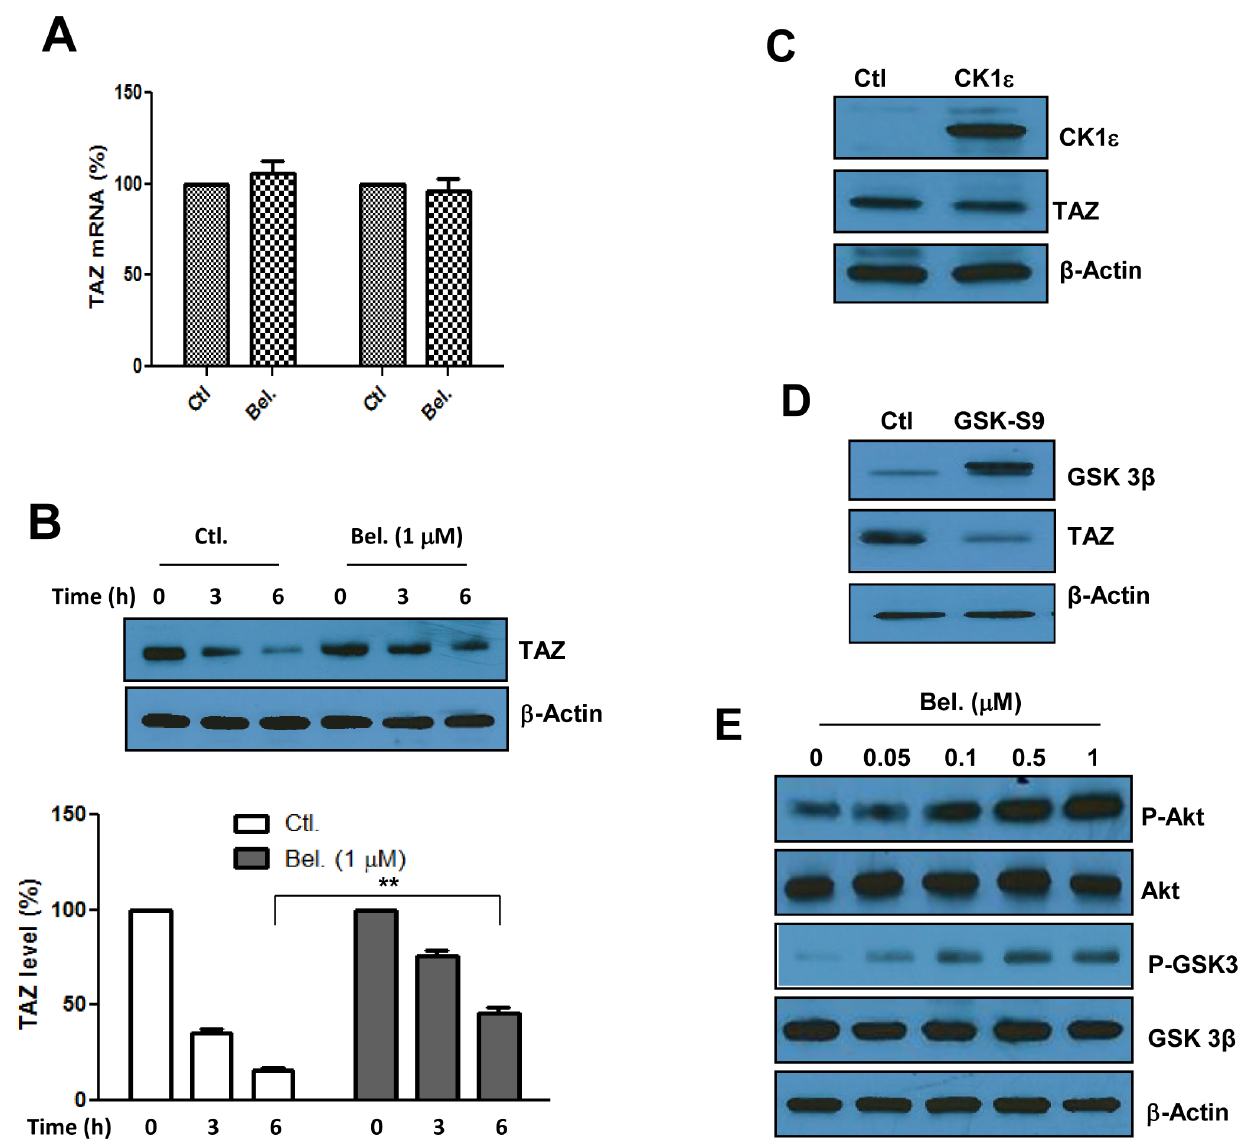
Figure 3. Belinostat-induces stabilization rather than expression of TAZ. Panel A. expression of TAZ in response to Belinostat (5 m M) measured quantitative PCR. Panel B. Effect of Belinostat on TAZ stabilization. SW480 cells were exposed to cycloheximide (CXH) at 10 m M concentration in the absence or the presence of Belinostat ( m M). Proteins were extracted at the indicated times after addition of the compounds and TAZ protein levels determined by Western blot. Band densities were quantified by the Image J software (NIH) and graphed. Data in graphs A and B represent average of three determinations 6 SE. Significance (p , 001) is shown in graph B between Belinostat-treated cells for 6 hours and the corresponding non-treated cells. Panels C and D. SW480 cells were transfected with genes coding for CK1 e or constitutively active GSK3 beta (GSK-S9) and TAZ protein levels determined by Western blot after 48 hours. Panel E. Effect of Belinostat on phosphorylation of Akt and GSK3 beta. The cells were exposed to the drug for 1hour in serum free medium and protein phosphorylation detected by Western blot using specific antibodies. Beta actin is used as a loading control in panels B, C, D and E.